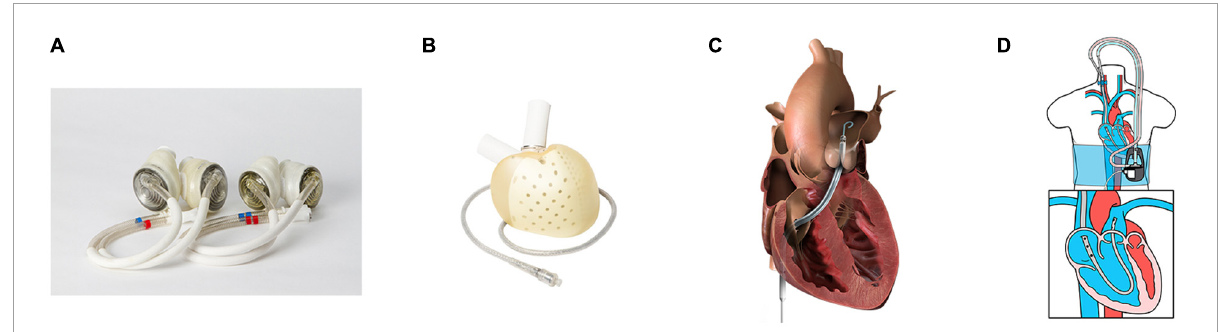
FIGURE1 Mechanical circulatory support (MCS) devices for right ventricular/biventricular failure. (A) SynCardia R (cid:13) total artificial heart 70 cc (left) and 50 cc (right), re-use from Villa et al. (60), (B) Aeson R (cid:13) total artificial heart (Image from Carmat SA, used with permission), (C) Impella RP R (cid:13) (Image from Impella RP instruction manual, used with permission), and (D) LifeSparc R (cid:13) pump with ProtekDuo R (cid:13) cannula (Image from Livanova Investor Day 2021 presentation, used with permission).